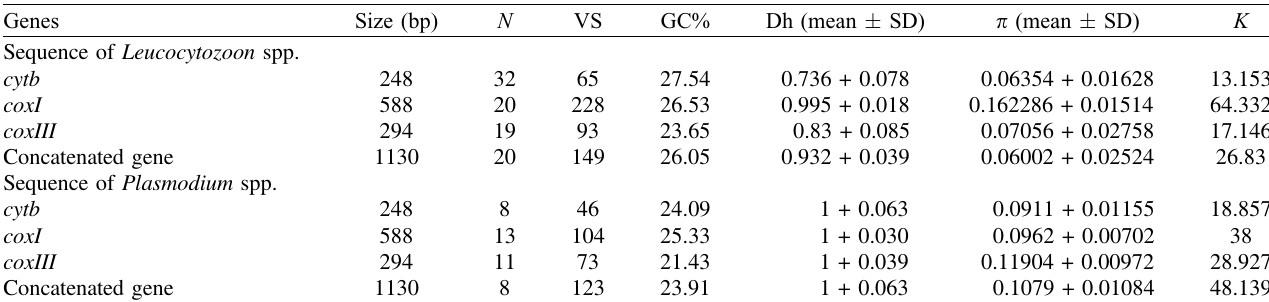
Table 3. Polymorphism and genetic diversity of the three mitochondrial and concatenated genes of Leucocytozoon spp. and Plasmodium spp. as detected in chicken samples in Thailand and other countries. Sequence of Leucocytozoon